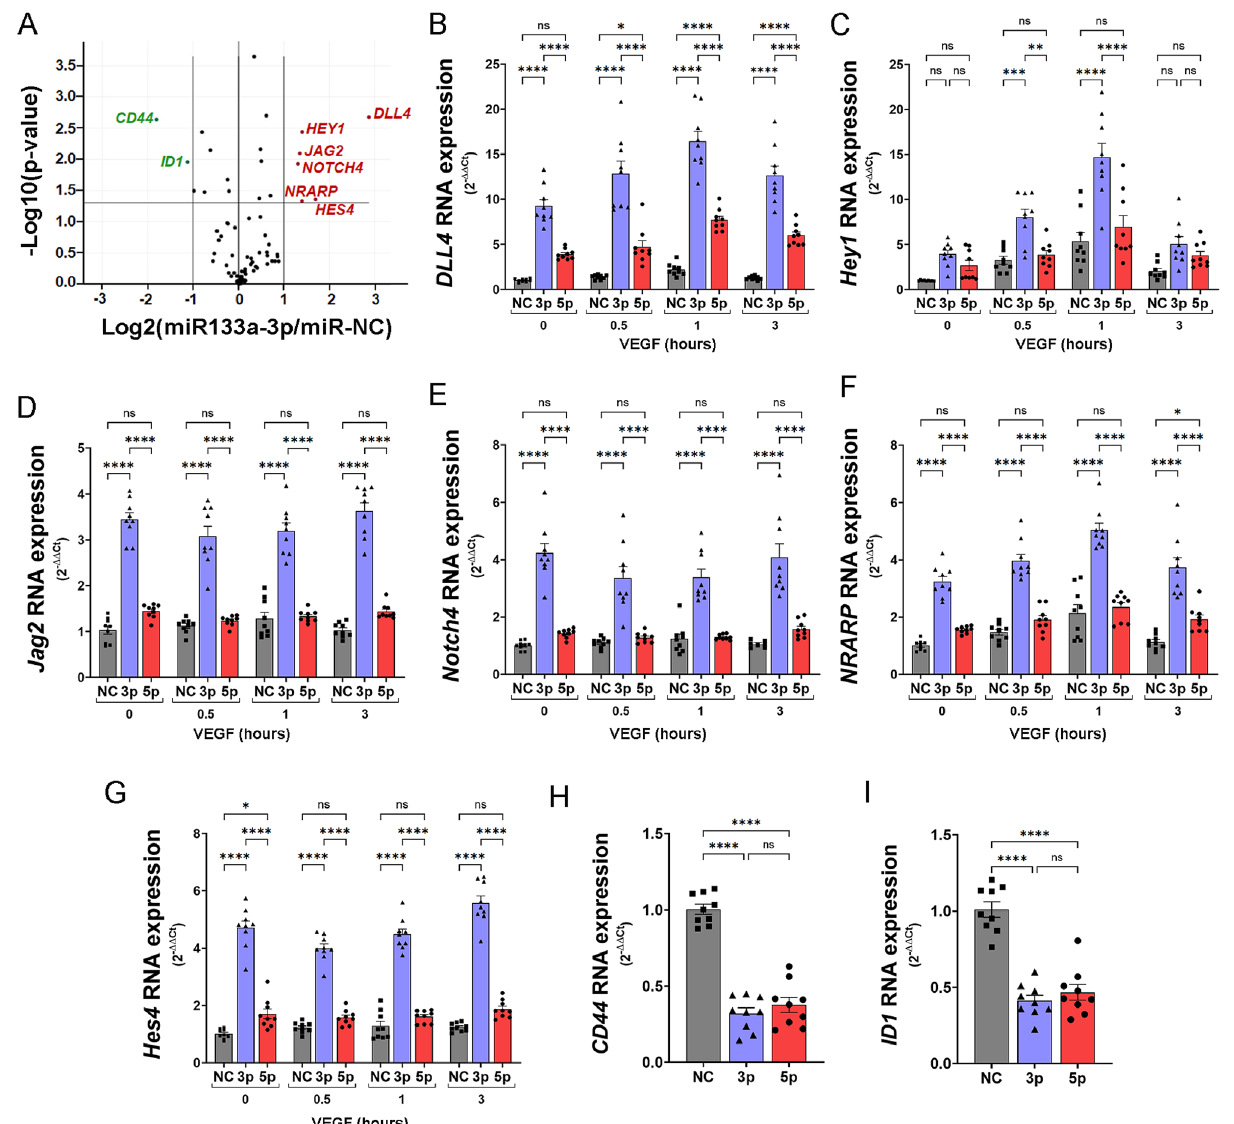
Figure 2. Aberrant expression of miR-133a in endothelial cells alters the expression of key regulators of DLL4-Notch signalling. ( A ) Volcano plot representation showing differential gene expression analysis of a RT2 Profiler PCR Array Human Notch Signalling Pathway Plus Kit (Ref PAHS-059Y, Qiagen) using RNA isolated from HUVEC transfected with miR-133a-3p or negative control (miR-NC) and stimulated for 1 h with VEGF-A 165 (50 ng/ml). Results of three independent experiments were analysed using GeneGlobe Data Analysis Center (Qiagen). Genes showing a Log2(miR-133a-3p/miR-NC) > 1 and − Log10( P value) P ≤ 0.05 were selected as upregulated (red). Those with Log2(miR-133a-3p/miR-NC) < -1, and − Log10( P value) P ≤ 0.05 were selected as downregulated (green). ( B – I ) HUVEC transfected with mimics for negative control (NC, grey bars), miR-133a-3p (3p, blue bars) or miR-133a-5p (5p, red bars) were left unstimulated (0 h) or stimulated with VEGF-A 165 (50 ng/ml) for the indicated times. RNA isolated from these cells were used to determine changes in gene expression using qPCR TaqMan Gene Expression Assays specific for each gene. Data are shown as mean ± SE, n = 9. Data were analysed for statistical differences by two-way ( B – G ) or one-way ( H – I ) ANOVA with post hoc Tukey’s comparison test. ns = non-significant; *, P ≤ 0.05; **, P ≤ 0.01; ***, P ≤ 0.001; ****, P ≤